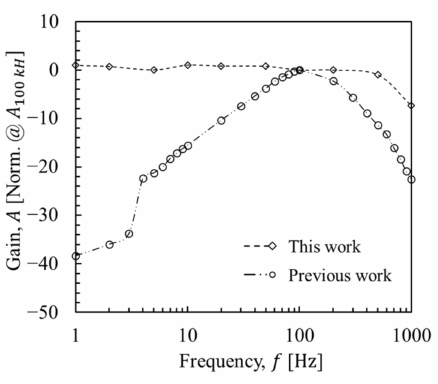
Figure 10. Frequency response of the ToGoFET probe in contact with an oxide film. The AC voltage was applied to the electrode pattern under the oxide film.